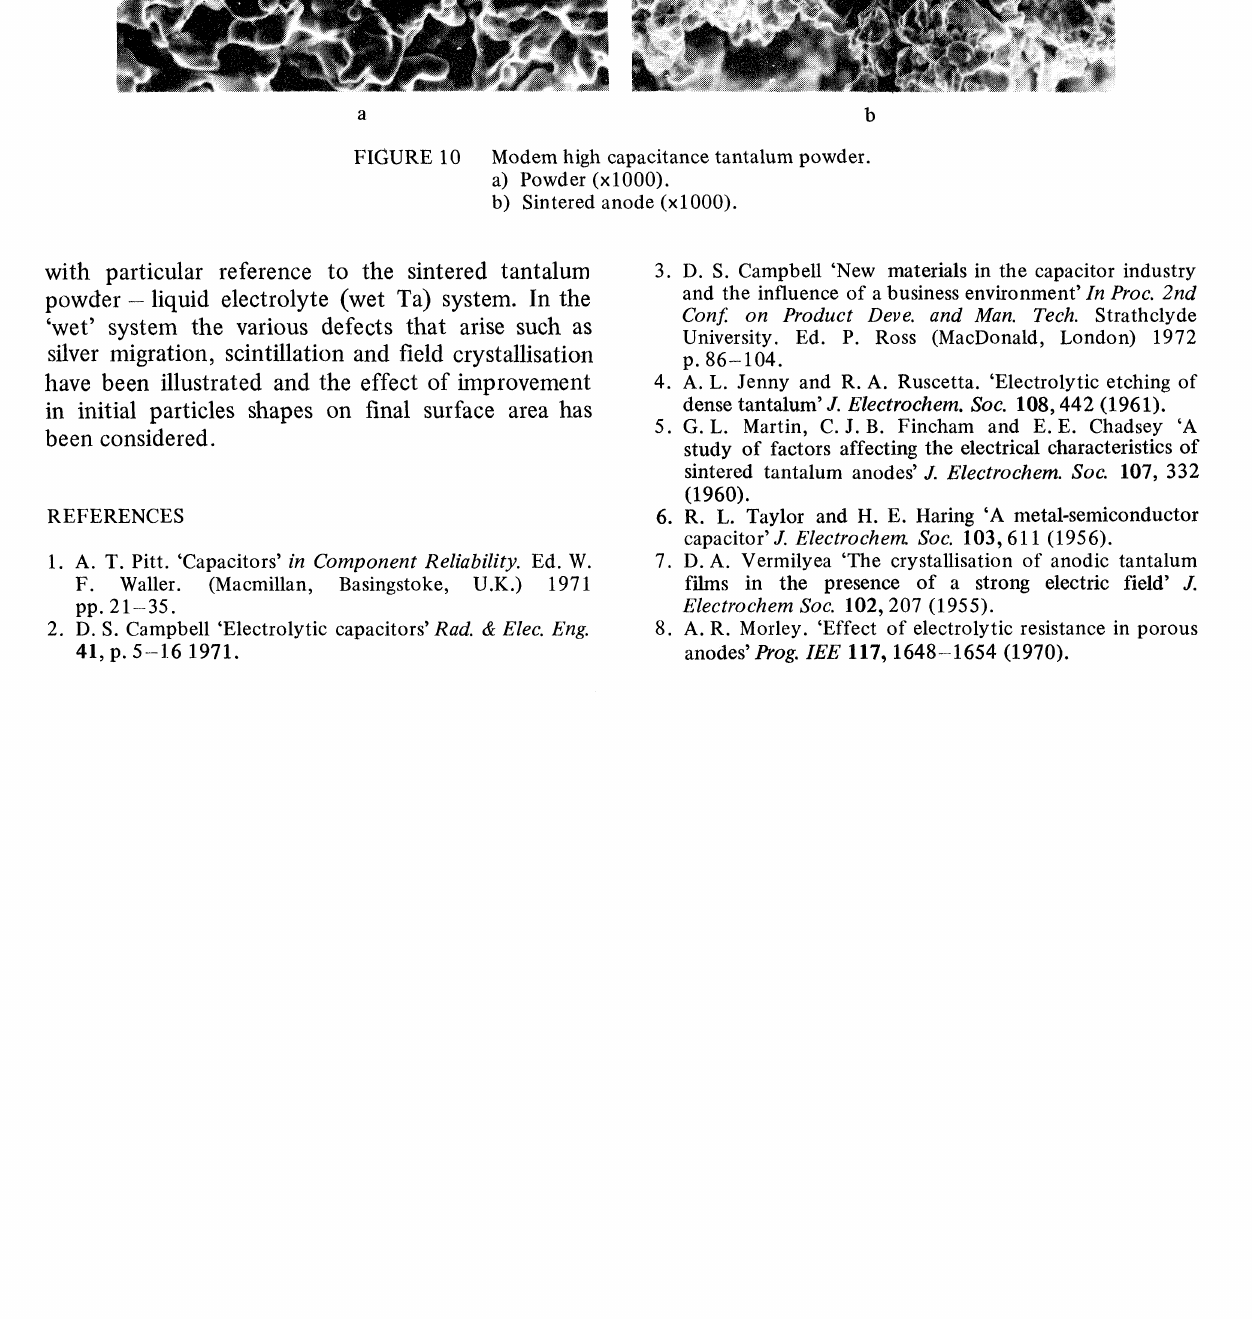
FIGURE 10 Modem high capacitance tantalum powder. a) Powder (xl000). b) Sintered anode